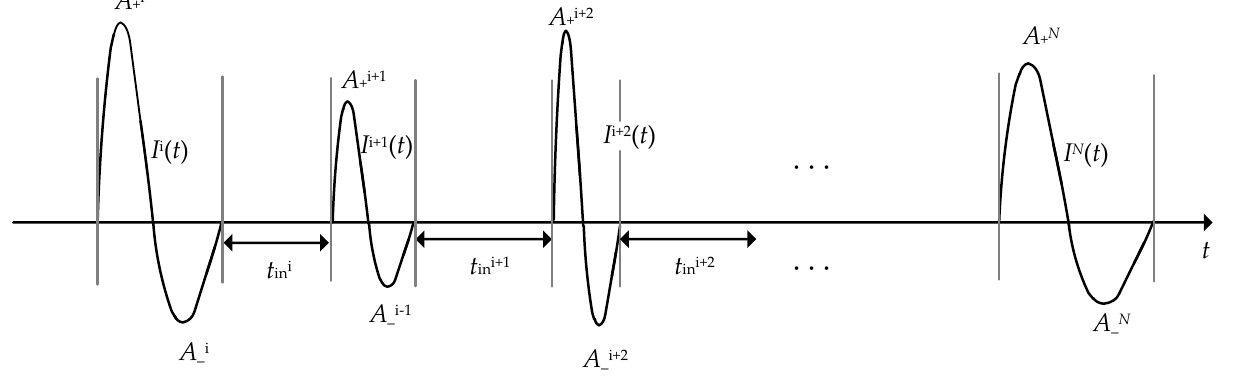
Figure 12. Schematic diagram of the random current pulse train. Single pulses are stretched to show their shapes in a pulse train.